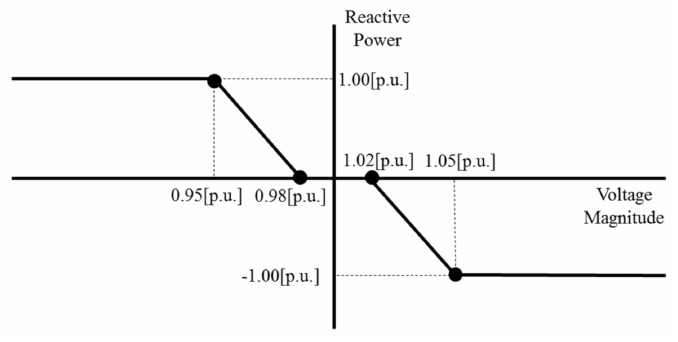
Figure 5. Volt/Var curve for the